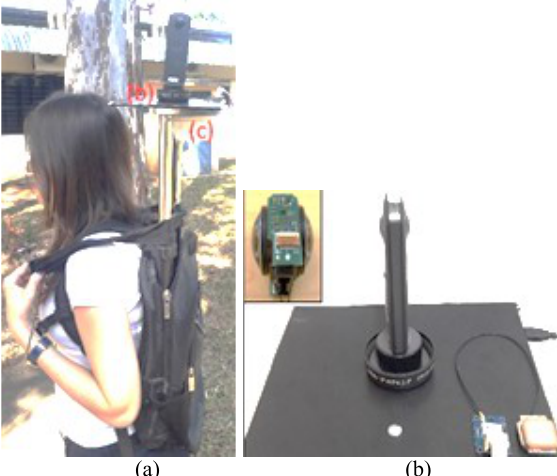
Figure 1. Personal mobile terrestrial system (PMTS) for a sequential data acquisition: (a) PMTS carried by an operator, (b) Ricoh Theta S camera (Campos et al.,